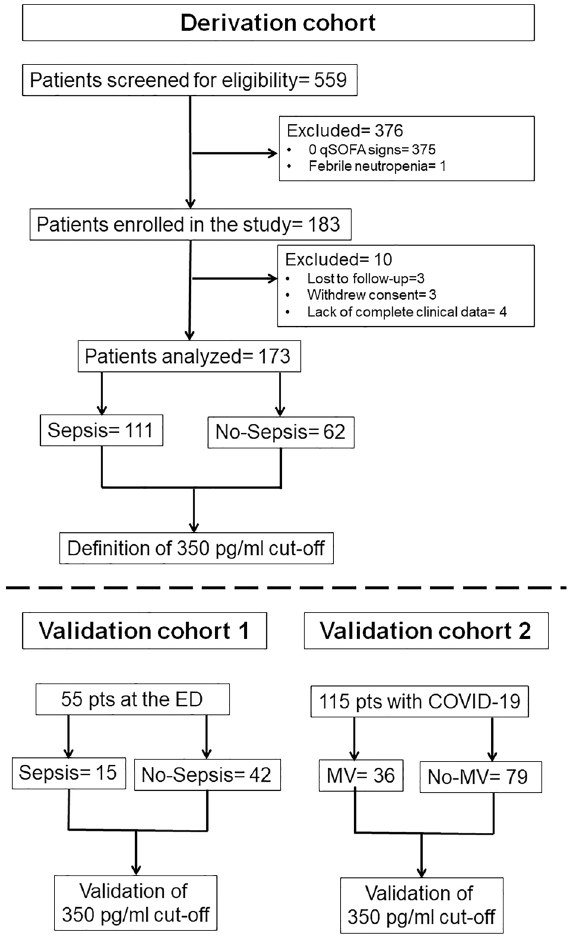
Figure 1. Study flowchart. The derivation cohort consisted of 173 patients recruited before the pandemic who had at least one sign of qSOFA. A cut-off of presepsin of more than 350 pg/ml was developed for the diagnosis of sepsis. This cut-off was validated in two cohorts: the validation cohort 1 was recruited from 57 consecutive admissions at the emergency department (ED) before the pandemic. The 350 pg/ml presepsin cut-off was applied for the diagnosis of sepsis the first 48 h post admission. The validation cohort 2 was recruited from 115 patients hospitalized for COVID-19 pneumonia. The 350 pg/ml presepsin cut-off was applied to demonstrate those who were in acute respiratory distress syndrome (ARDS) in need of mechanical ventilation (MV) the next 48